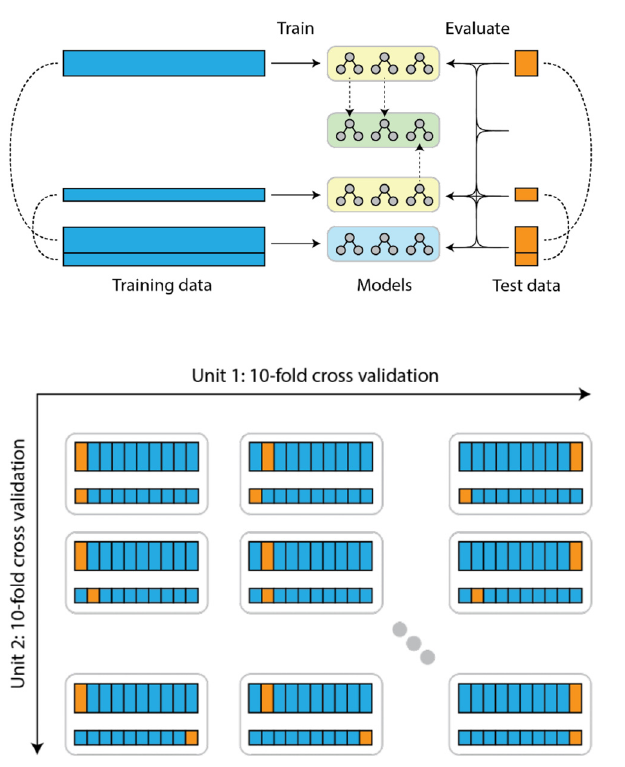
Figure 4: Cross-validation in the FL